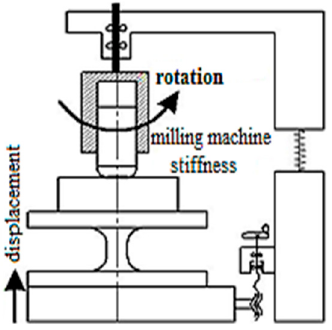
Figure 3. Loading schematics (new).